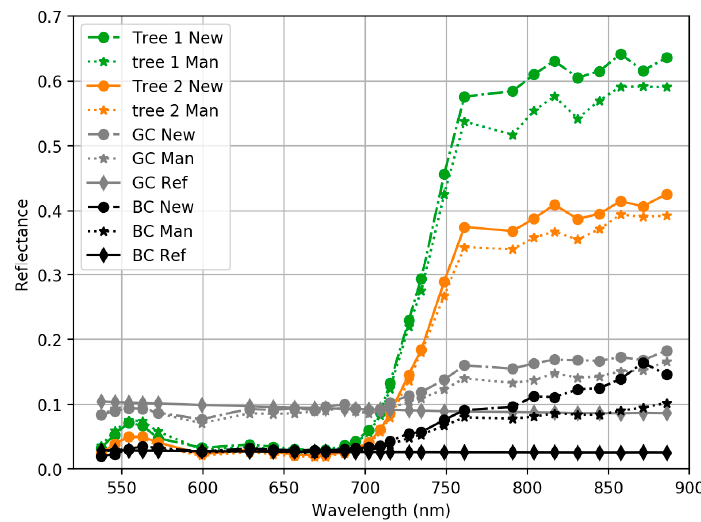
Figure 18. ( a ) False-colour reflectance mosaic of vertical flight f1 with FPI green, red and NIR range bands; ( b ) Part of the point cloud coloured with the spectral data, including locations of reference panels and measured trees.